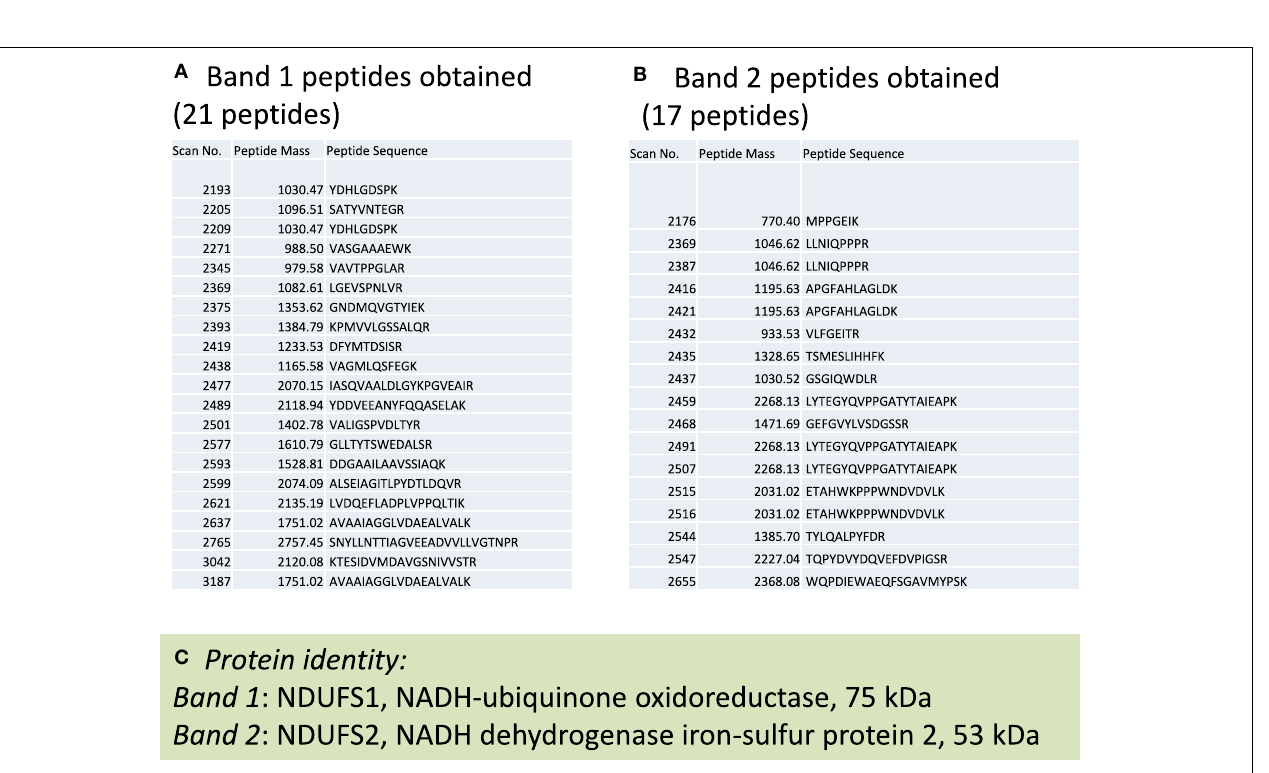
Frontiers in Physiology |